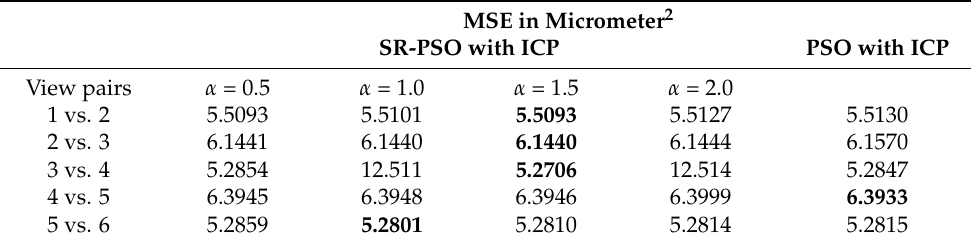
Table 8. MSE from SR-PSO and PSO for the orthodontic-tooth model (the best value is in bold).